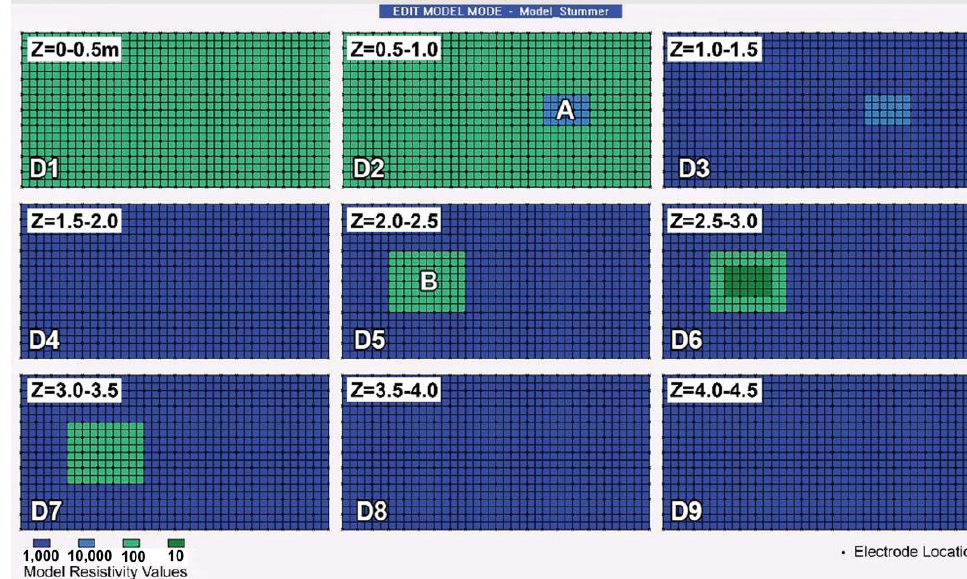
Figure 5. Synthetic Stummer’s model. Figure 6. Synthetic Stummer’s